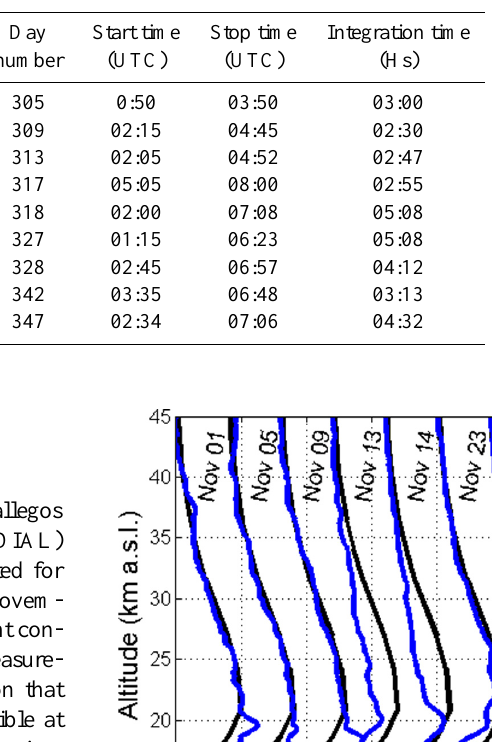
Table 3. Lidar measurements considered in this study.